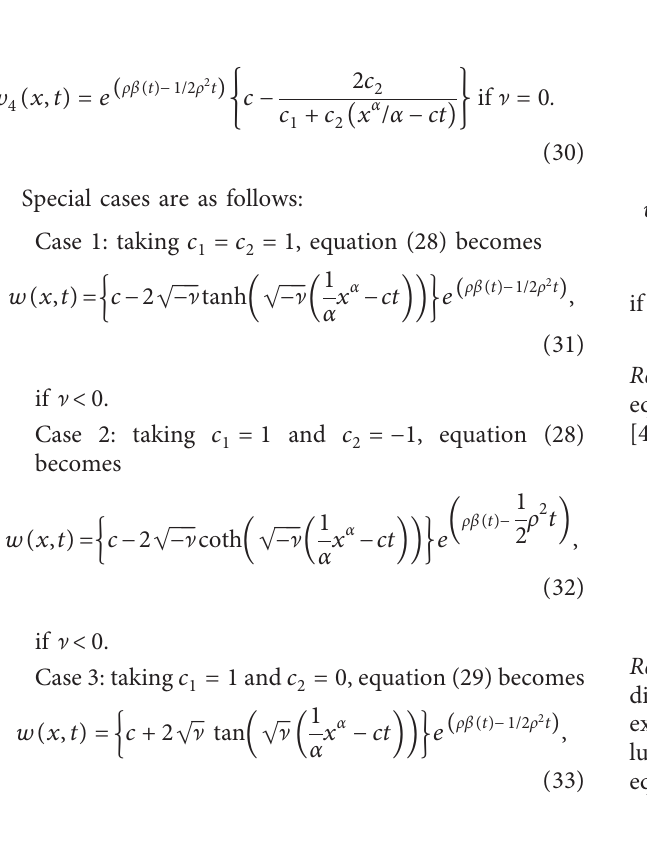
Figure 1: The solution w in equation (21) with α �